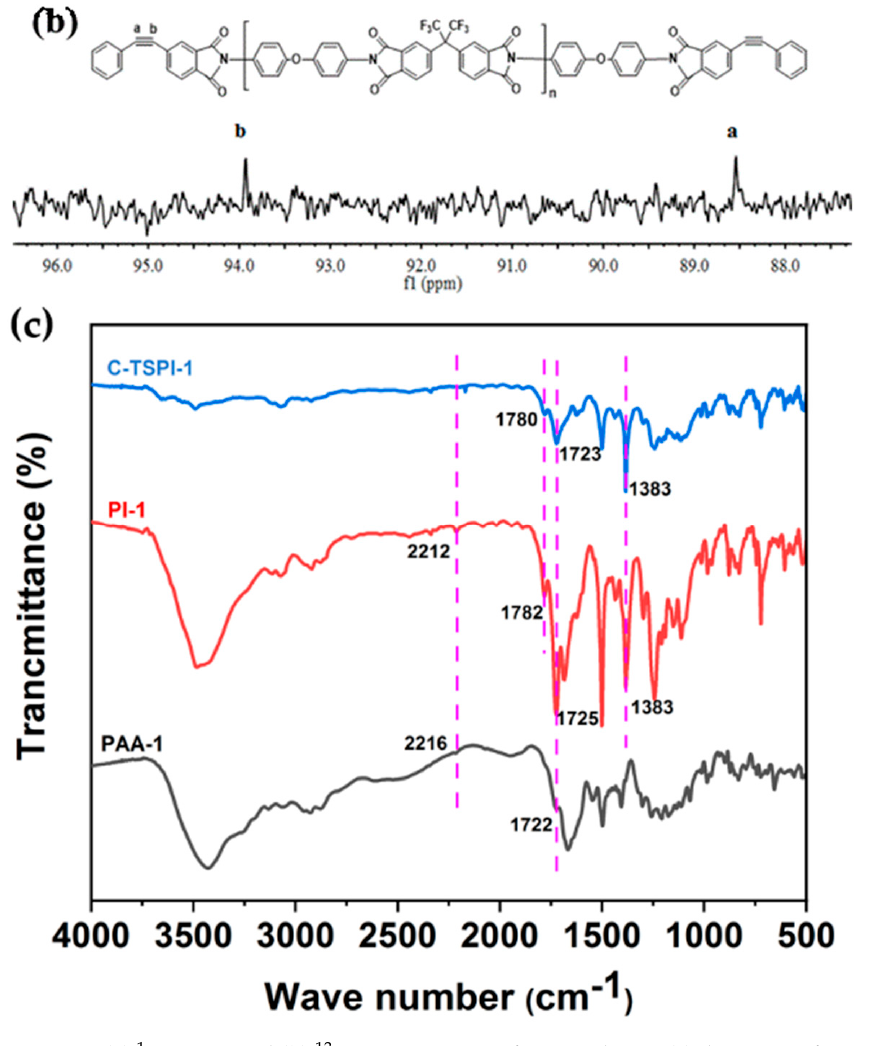
Figure 2. ( a ) 1 H-NMR and ( b ) 13 C-NMR spectra of uncured PI-1; ( c ) the FT-IR of PAA-1 powders, PI-1, and cured PI-1.